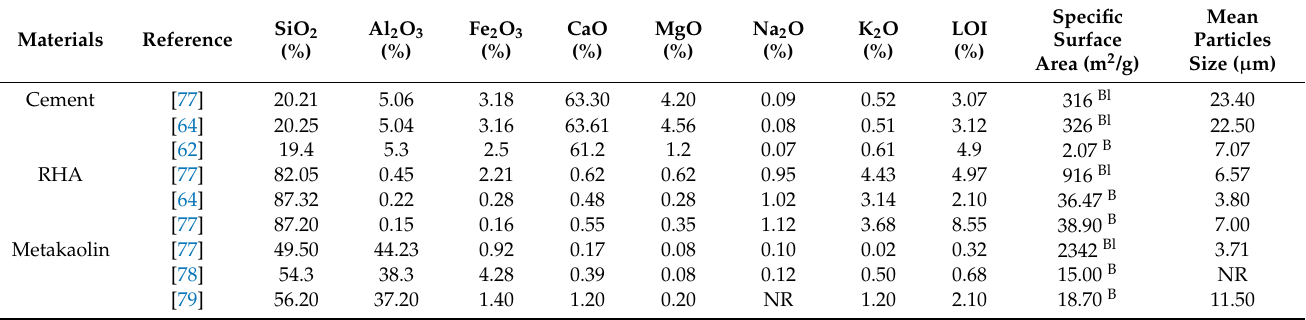
Table 1. Properties of cement, RHA, and